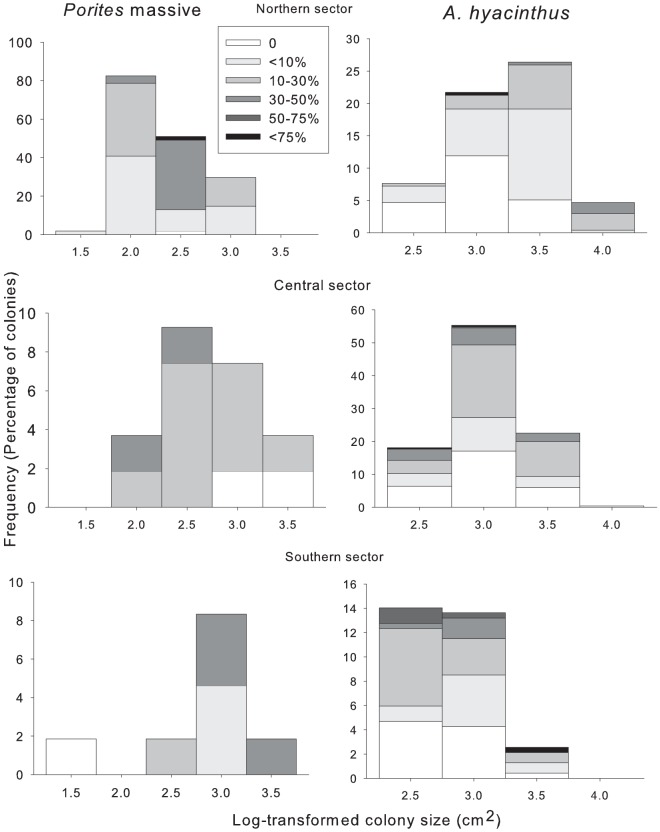
Size-frequency distributions (percentage of colonies) and percentage partial mortality for each size class in each latitudinal sector for Porites massive, and Acropora hyacinthus.Size classes were log10 transformed estimates of colony surface area.